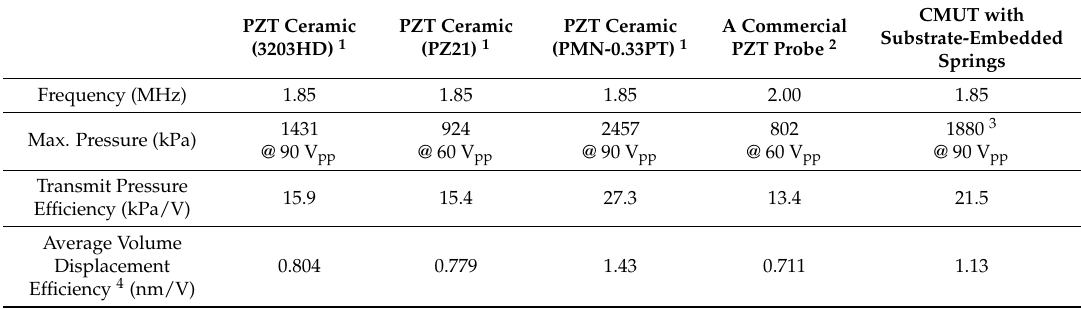
Table 2. Transmission performance comparison between PZT ceramics 3203HD, PZ21 and the CMUT with substrate-embedded